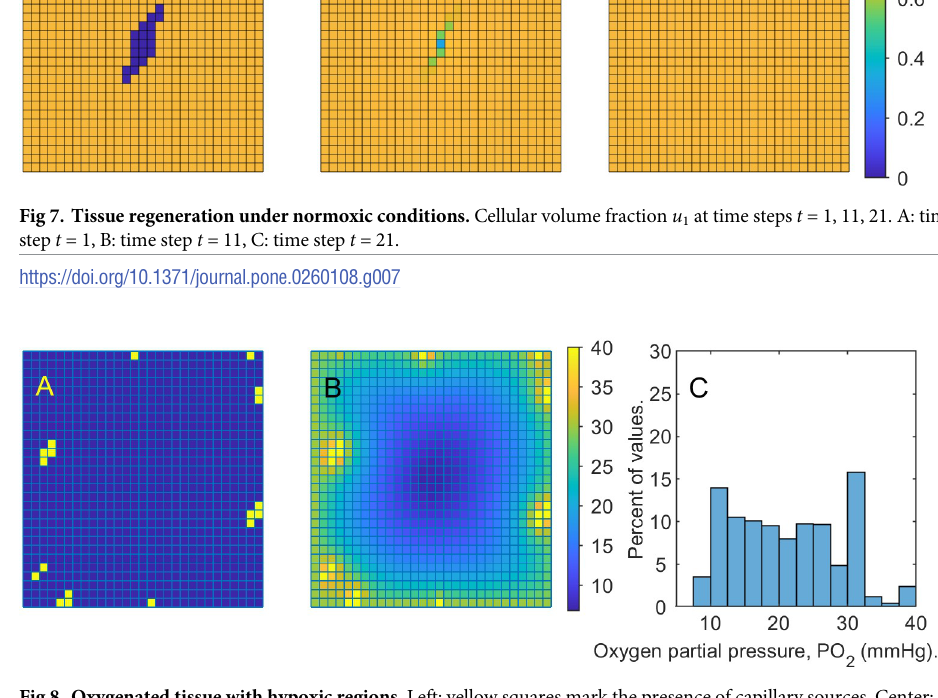
Fig 8. Oxygenated tissue with hypoxic regions. Left: yellow squares mark the presence of capillary sources. Center: oxygenation levels of the domain with the capillary sources as in the picture on the left and no damaged cells. Darkest blue indicates hypoxic locations. Right: PO 2 histogram corresponding to the tissue sample in the center. Values below 10 are considered hypoxic.